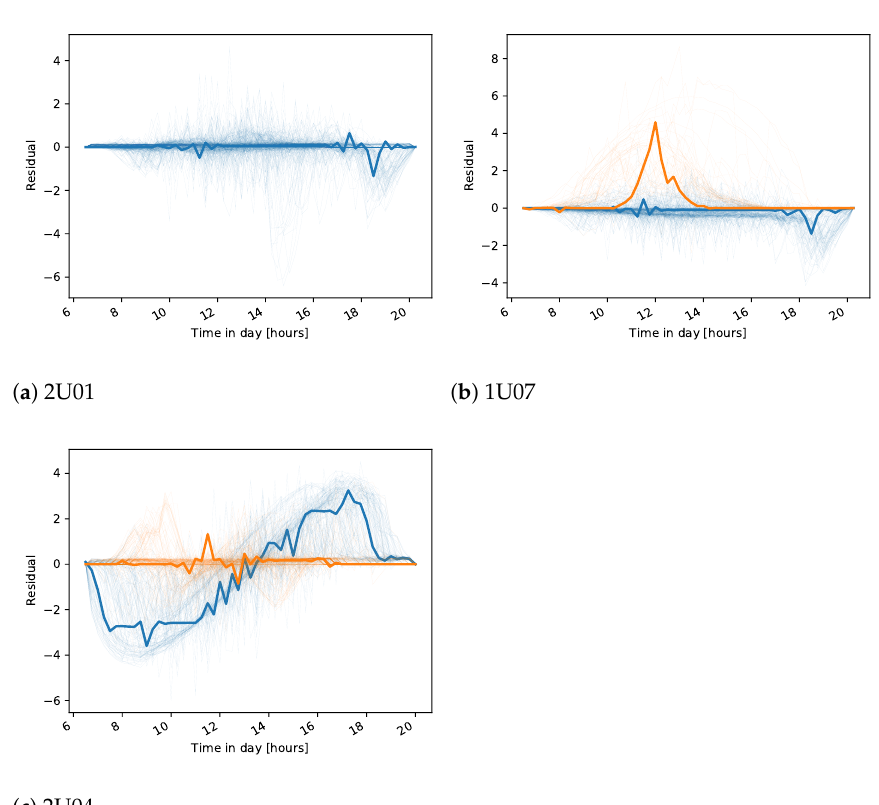
Figure 11. Clusters obtained from the daily residuals of DC current predictions for several inverters in plant